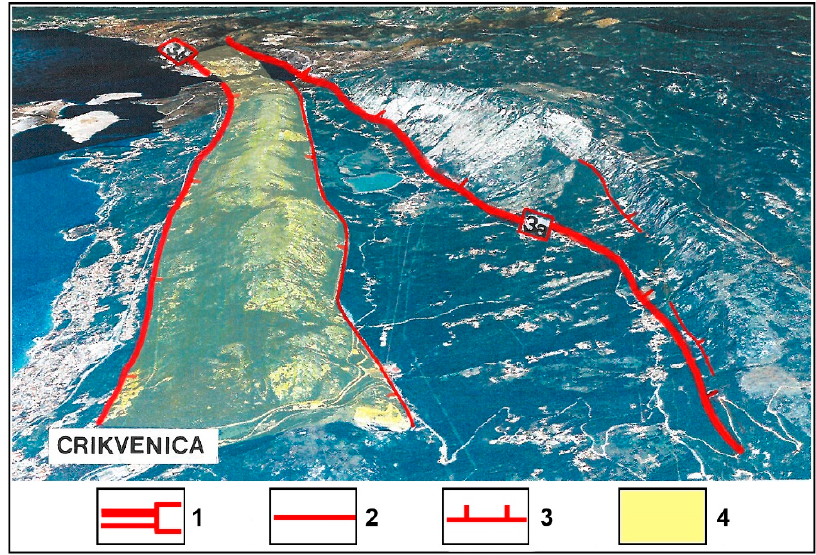
Figure 10. Local reverse structure in Crikvenica area due to compression in the contact area of regional structural units (Google Earth). Legend: 1—Major Ilirska Bistrica–Rijeka fault (3a) and its main branch (3b); 2—other faults in the wider zone; 3—reverse faults; and 4—local elevated structure with reverse faults of opposite vergence along their walls.